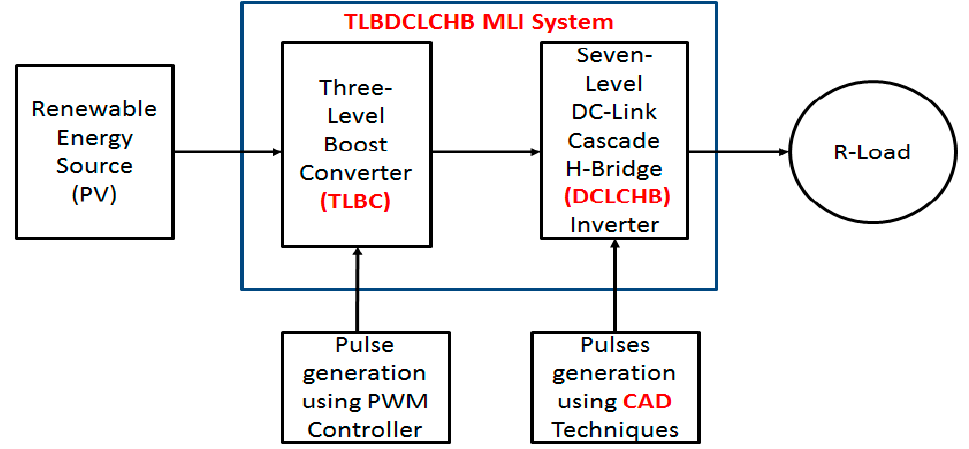
Figure 1. Block diagram of the proposed (TLBDCLCHB MLI) system.